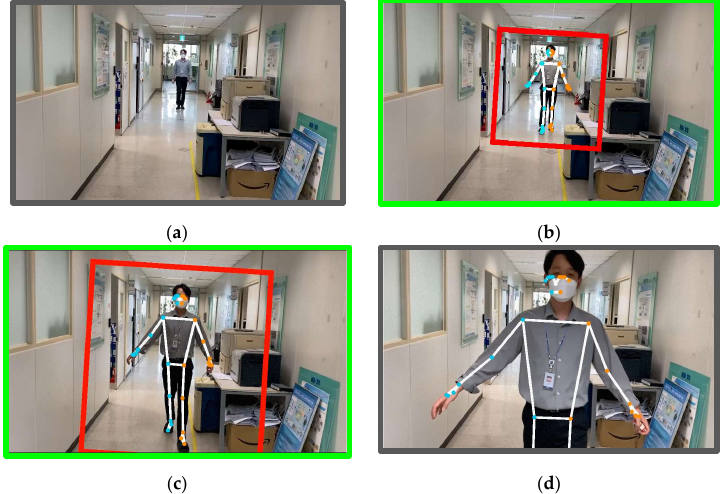
Figure 8. Posture detection and estimation based on the distance: ( a ) 7.0 m; ( b ) 6.0 m; ( c ) 2.5 m; ( d ) 1.0